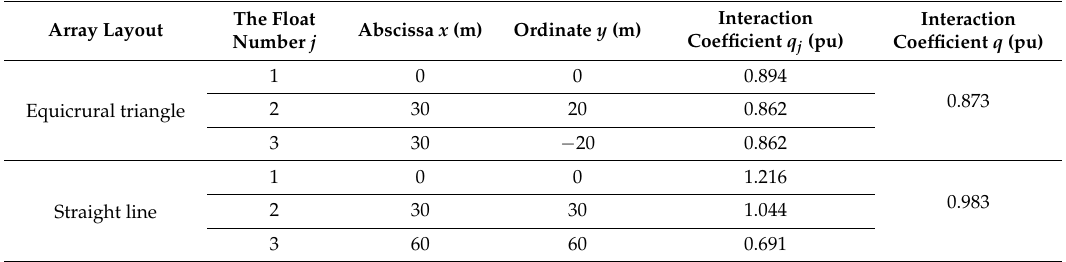
Interaction Interaction Coefficient q j (pu) Coefficient q (pu) 0.873 2 30 20 0.862